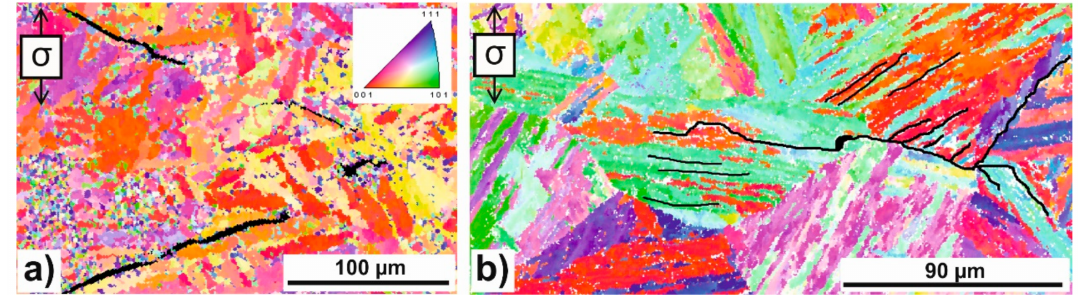
Figure 12. EBSD scan of uncharged X3 specimen: ( a ) in pressurized helium and ( b ) in pressurized hydrogen